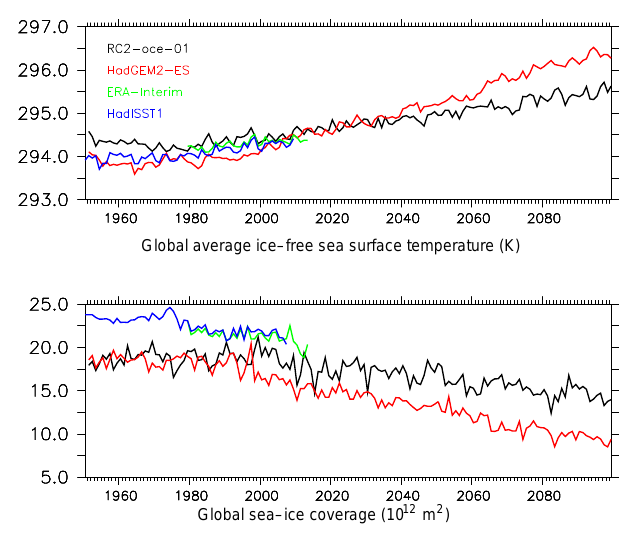
Figure 11. Global annual average (ice-free) SSTs (in K, upper panel) and SIC (in 10 12 m 2 , lower panel) of simulation RC2-oce-01 (1950–2099, black) compared to prescribed SSTs/SICs of simula- tions RC1-base (HadISST, blue), RC2-base (HadGEM2-ES, red) as described in Sect. 3.3, and of ERA-Interim (green) as applied in the nudged simulations